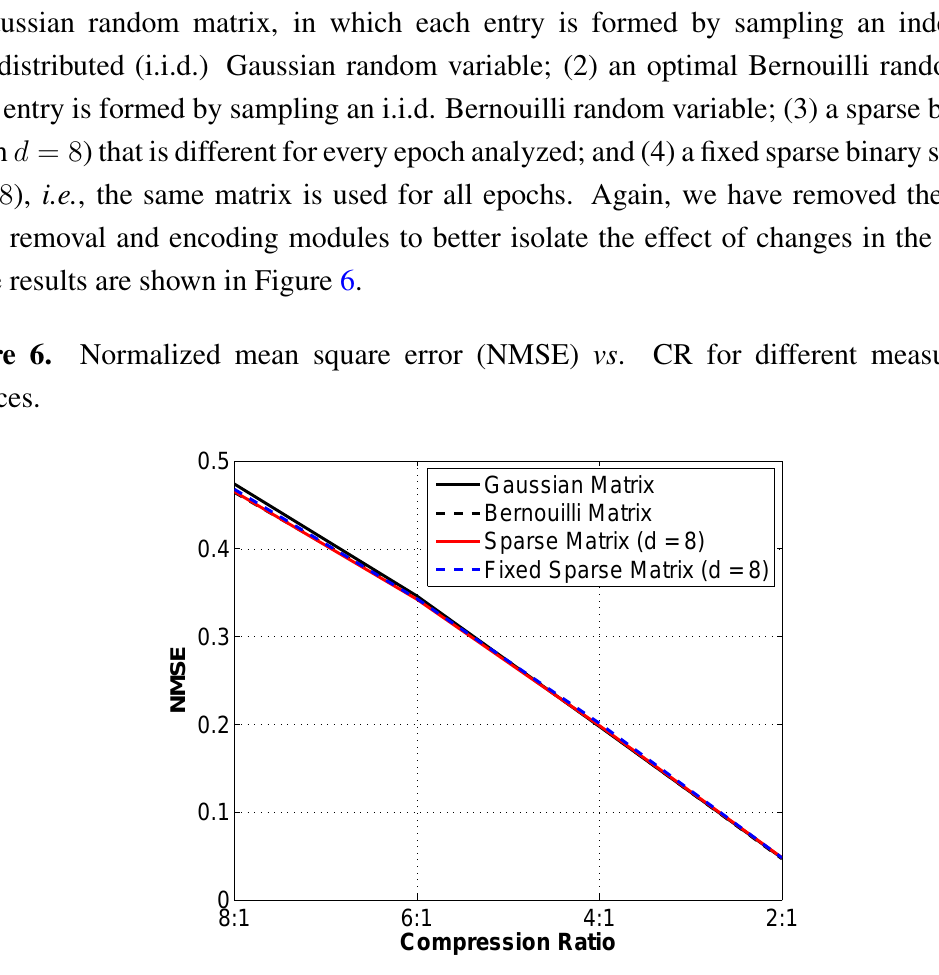
Compression Ratio